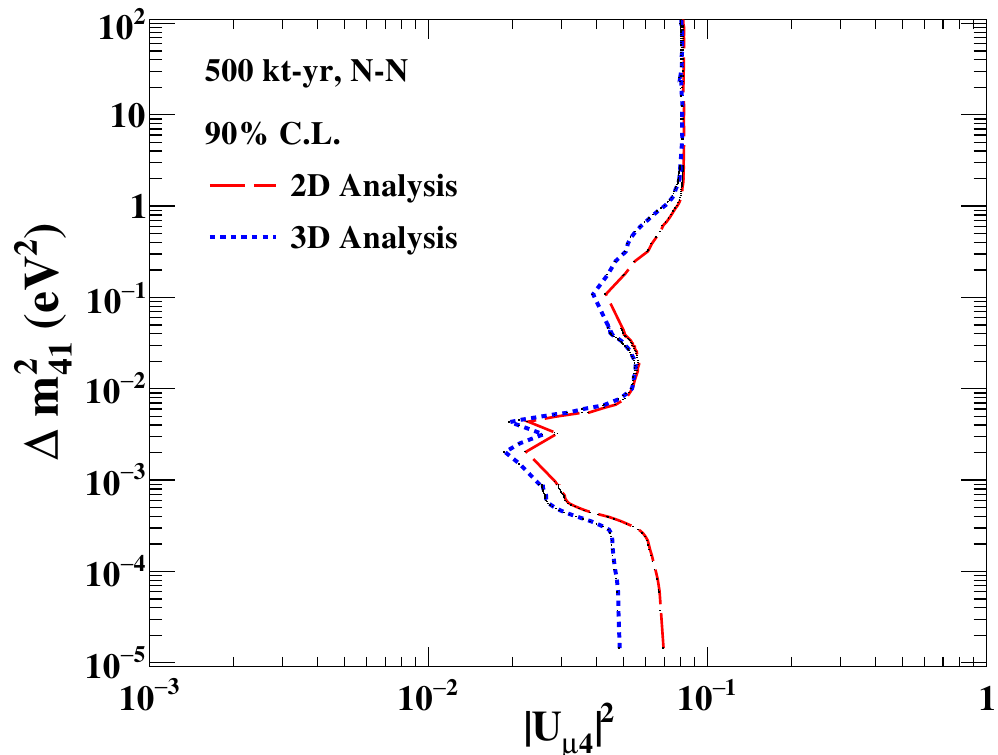
Figure 6 . The 90% C.L. exclusion contours in the (cid:1) m 2 (information on muon momentum only), and 3D analysis (inclusion of event-by-event information on hadron energy), for 500 kt-yr exposure. For illustration, we have used the N-N mass ordering